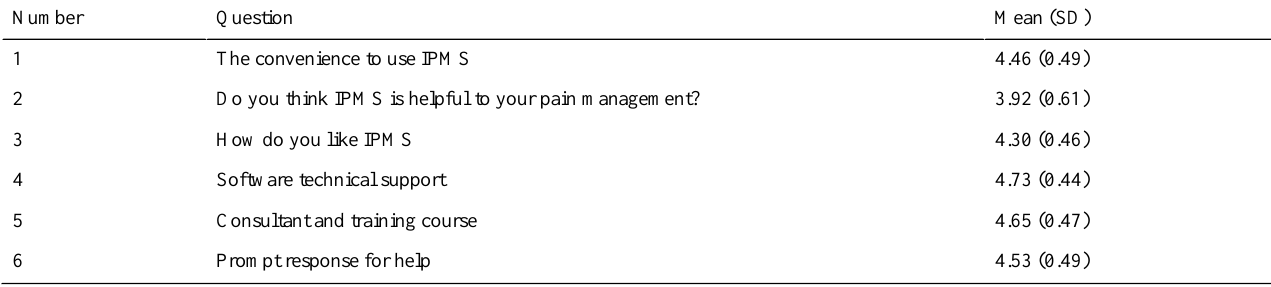
Table 4. Usability and satisfaction after 2 weeks (n=25). The rate was 1 (extremely dislike it) to 5 (extremely like